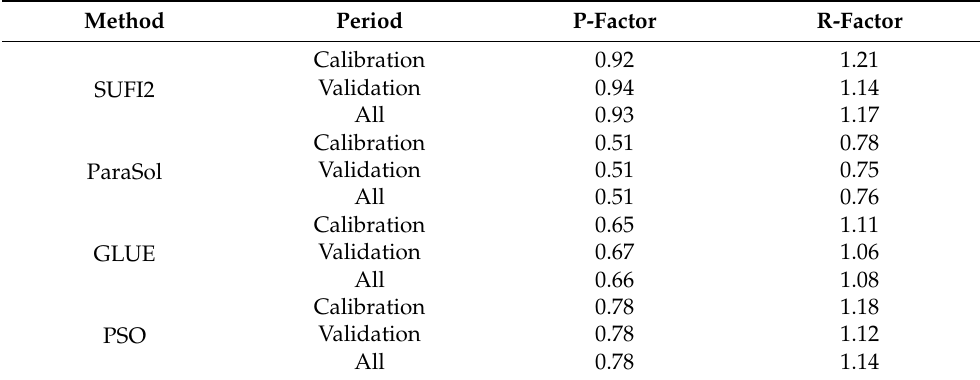
Figure 4. Comparison of the daily simulated streamflow with 95PPU against the observed streamflow by using SUFI-2 ( a ), ParaSol ( b ), GLUE ( c ) and PSO ( d ) methods. Table 4. Metrics of the four uncertainty analysis methods over the calibration (1975 to 1989) and validation (1990 to 2004) periods at daily